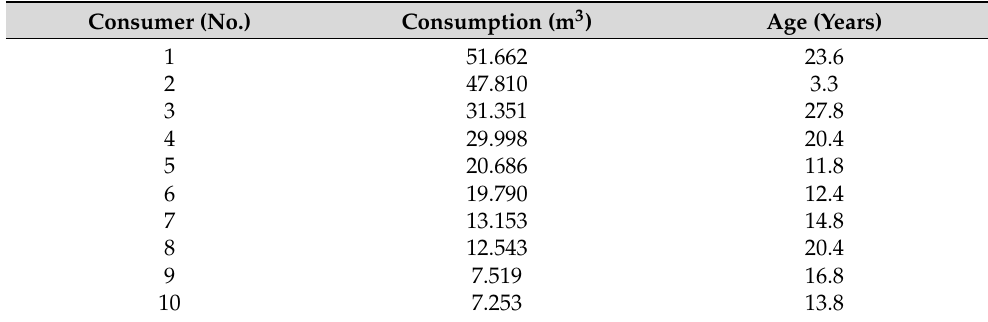
Table 8. The age of flow meters with the most significant consumption in the municipality. Consumer